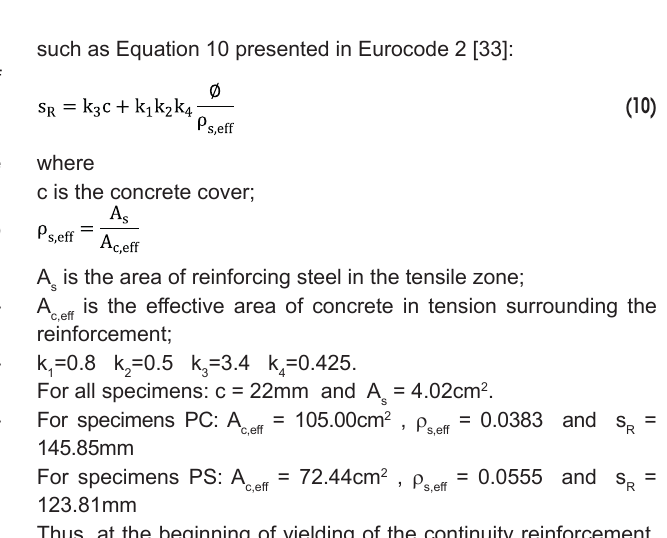
Figure 24 Moment-rotation curve: specimens PS1 and PS2